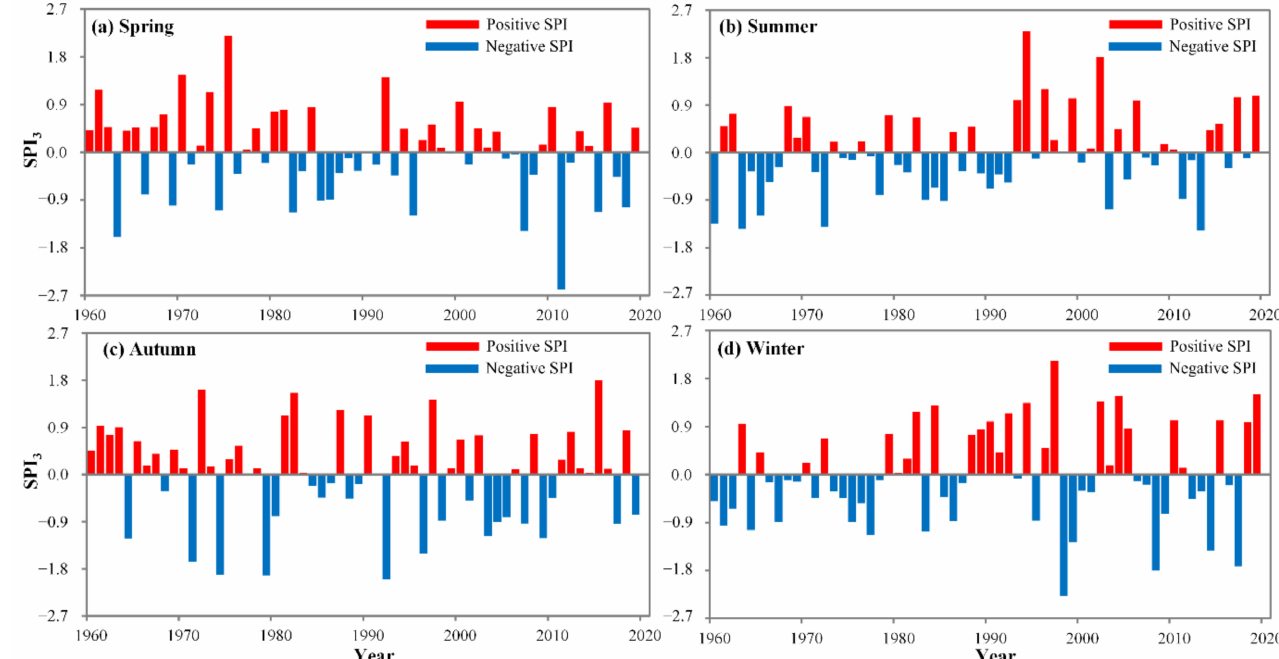
Figure 5. Temporal variations of seasonal SPI on a 3-month time scale in HSDC, 2000–2019. ( a ) Spring; ( b ) summer; ( c ) autumn; and ( d )